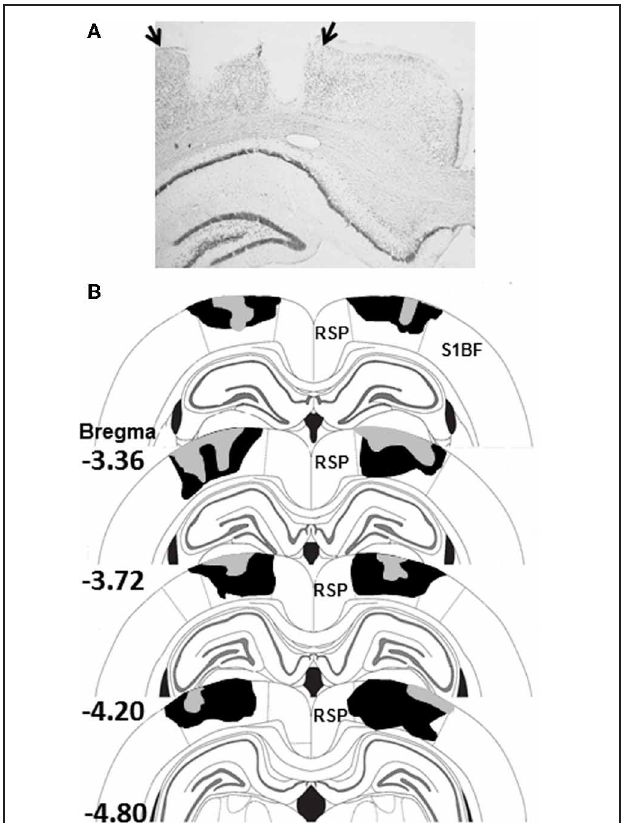
FIGURE 2 | (A) Photomicrograph of a PPC-lesion illustrating typical damage to PPC on one side of the brain. The arrows indicate the boundaries of PPC. (B) Schematic diagram indicating the largest (black) and smallest (gray) lesions of PPC in Experiment 1 (adapted from Paxinos and Watson, 2007). Abbreviations: RSP, restrosplenial cortex; S1BF, somatosensory cortex barrel